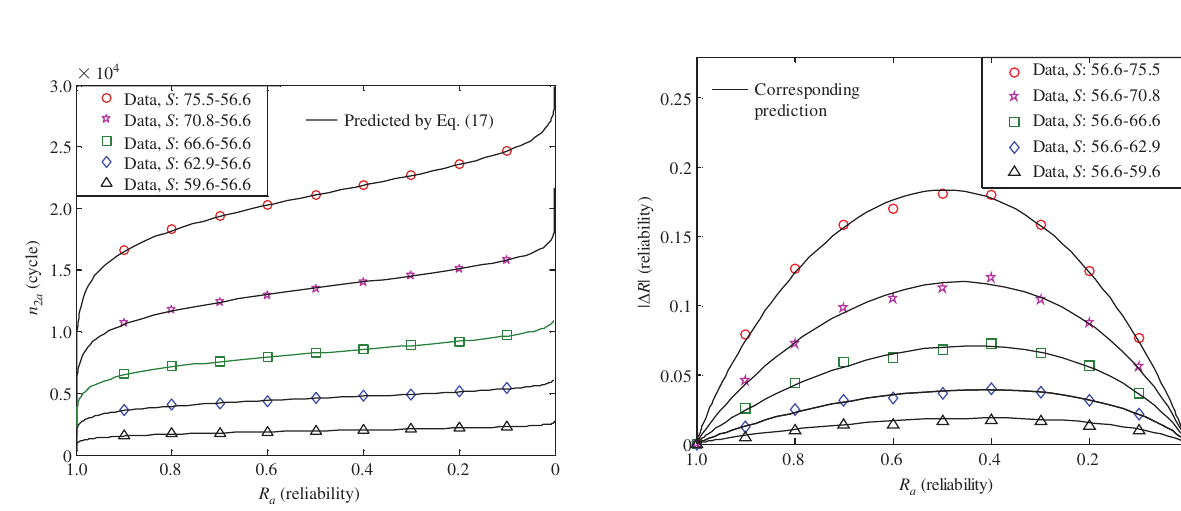
Figure 5 Comparison between the predicted transition period and simulation data for composites under various high-low fatigue load- ing adjustment.